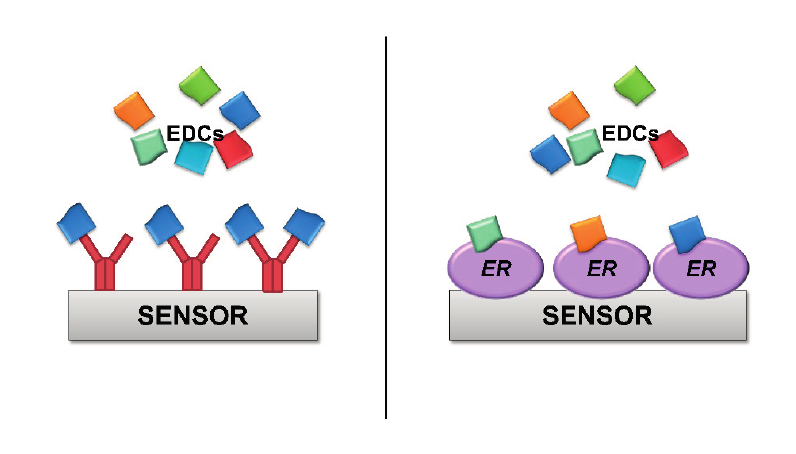
Figure 2. Schematic representation of a biosensor utilizing either antibodies (left) or ER protein (right) as bio-recognition elements. Antibodies, shown in red, are highly sensitive and usually highly specific. Each antibody would bind single EDCs and would not be able to detect the EDC. An ER based sensor would be able to detect the presence of any EDCs, even initially unknown compounds.